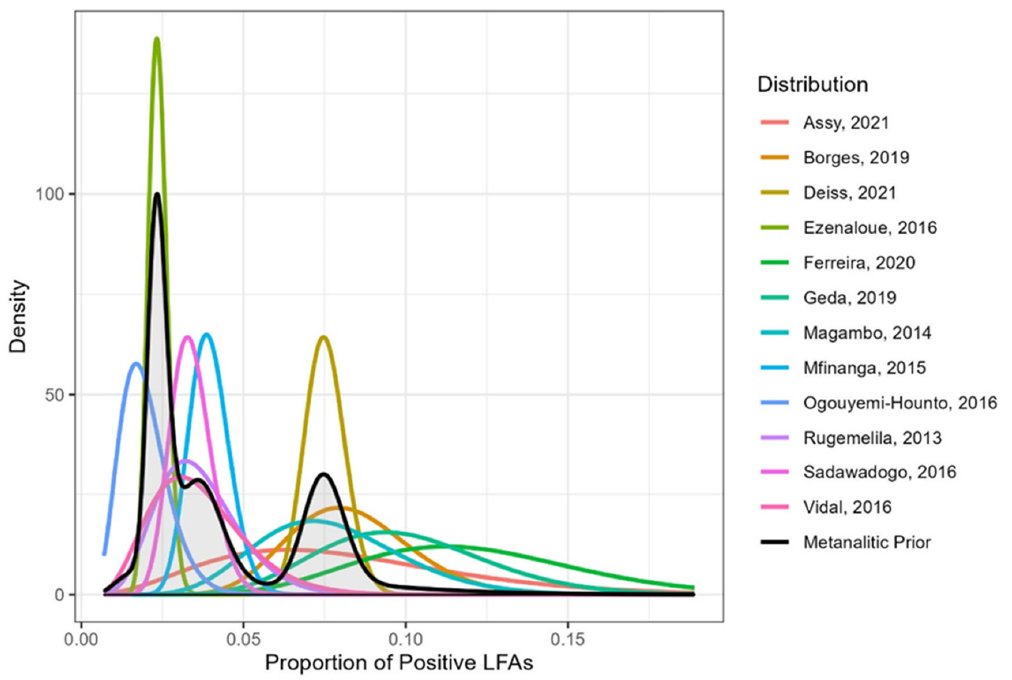
Figure 1. Densities related to each study and the meta-analytic prior distribution for the proportion of positive LFAs [19–21,23–31] .